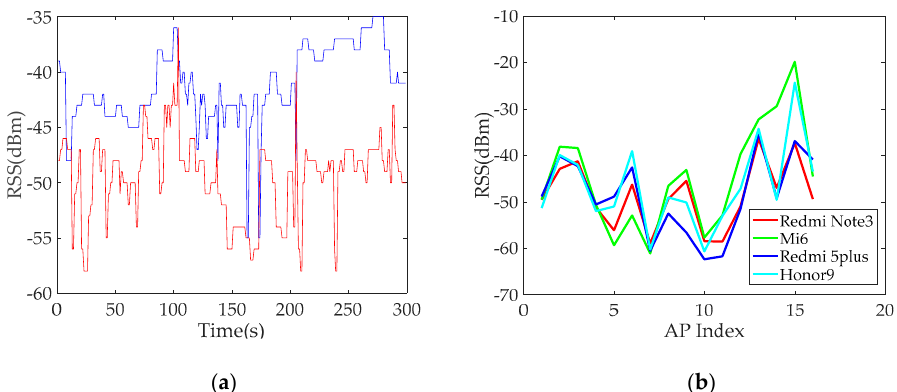
Figure 1. Variations in received signal strength (RSS) values resulting from different conditions: ( a ) The RSS value collection from the same access point (AP) using two heterogeneous smartphones at the same location and ( b ) the RSS value collection from the 16 APs using heterogeneous smartphones at the same location.